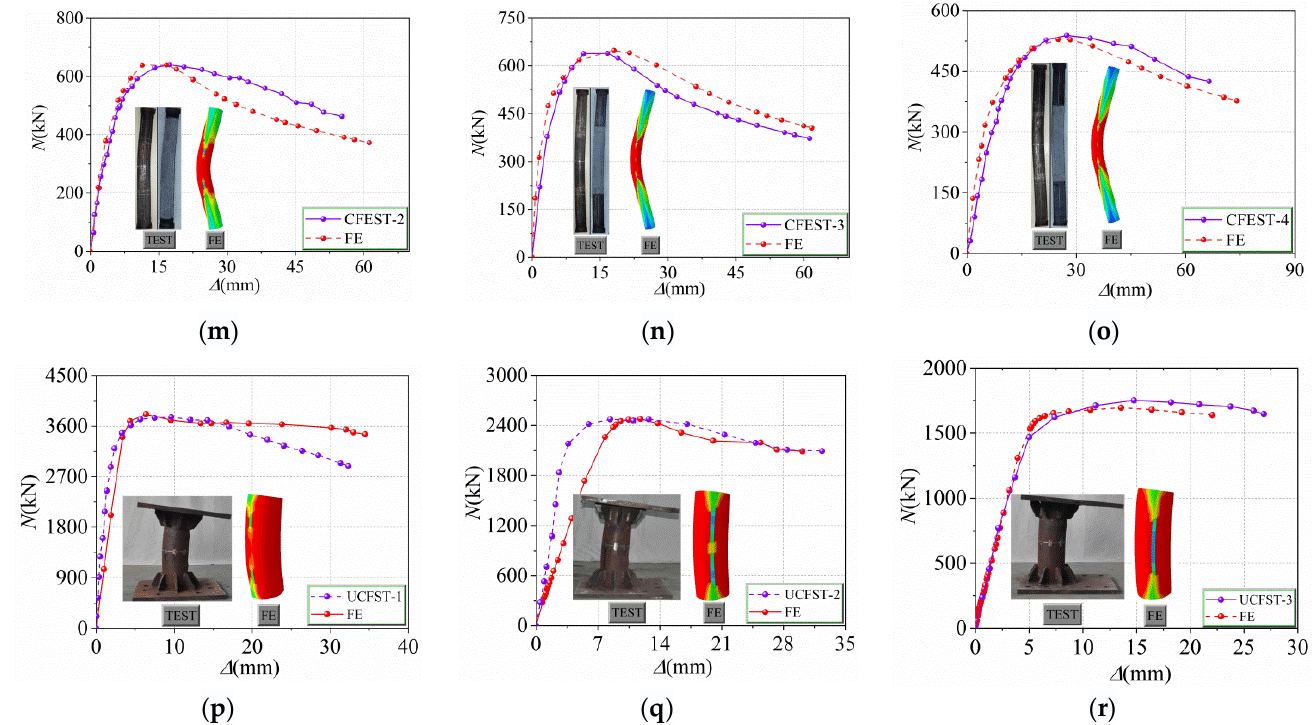
Figure 3. Comparisons for load–displacement curves between simulation and test results: ( a ) UCS-1; ( b ) UCS-2; ( c ) UCS-3; ( d ) UCS-4; ( e ) UCS-5; ( f ) CESC-1; ( g ) CESC-2; ( h ) S25-25 a; ( i ) S28-50 a; ( j ) S10-80 a; ( k ) S20-50 a; ( l ) L-Ma-35-25; ( m ) L-Ma-35-50; ( n ) L-Ma-50-25; ( o ) L-Ma-50-50; ( p ) UCFST-1; ( q ) UCFST-2; ( r ) UCFST-3.